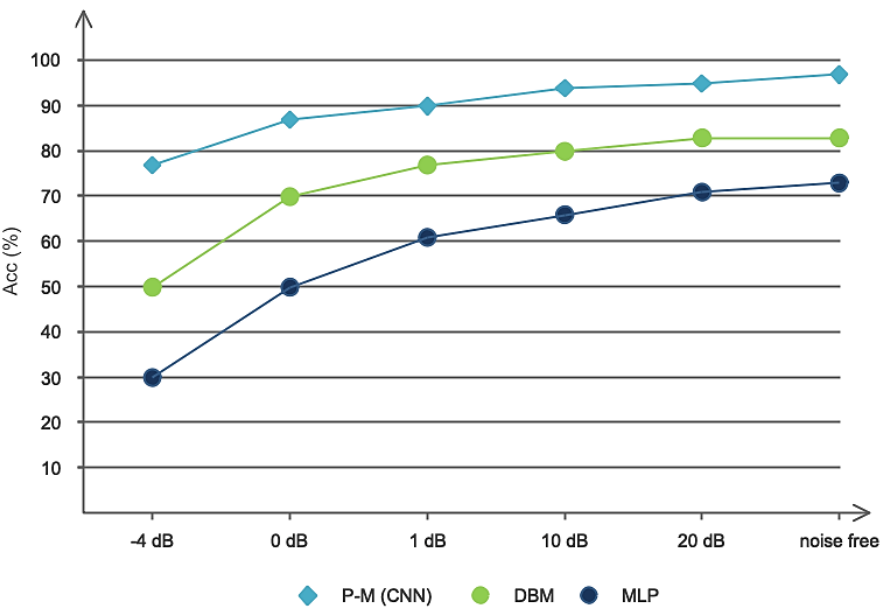
Figure 16. Accuracy of the proposed network versus SNR in additive white Gaussian noise.